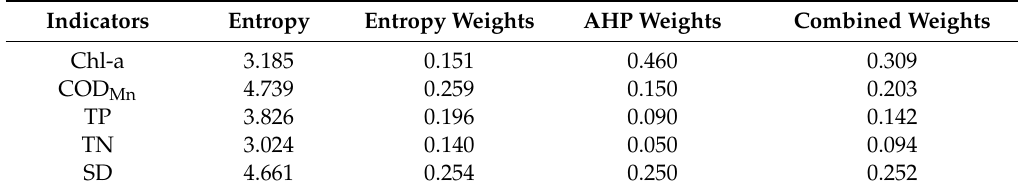
Table 4. Weights of indicators for eutrophication